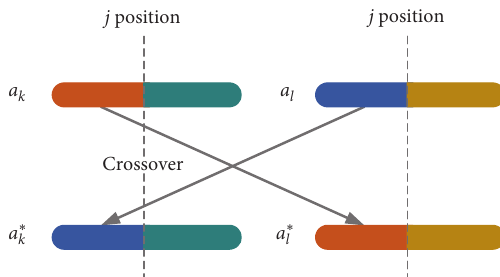
Figure 1: Portable pulmonary function device (Contec Ltd.). The CEV and CPFR values can be displayed on the screen and stored in the device. The data can be transmitted to the computer through Bluetooth function.